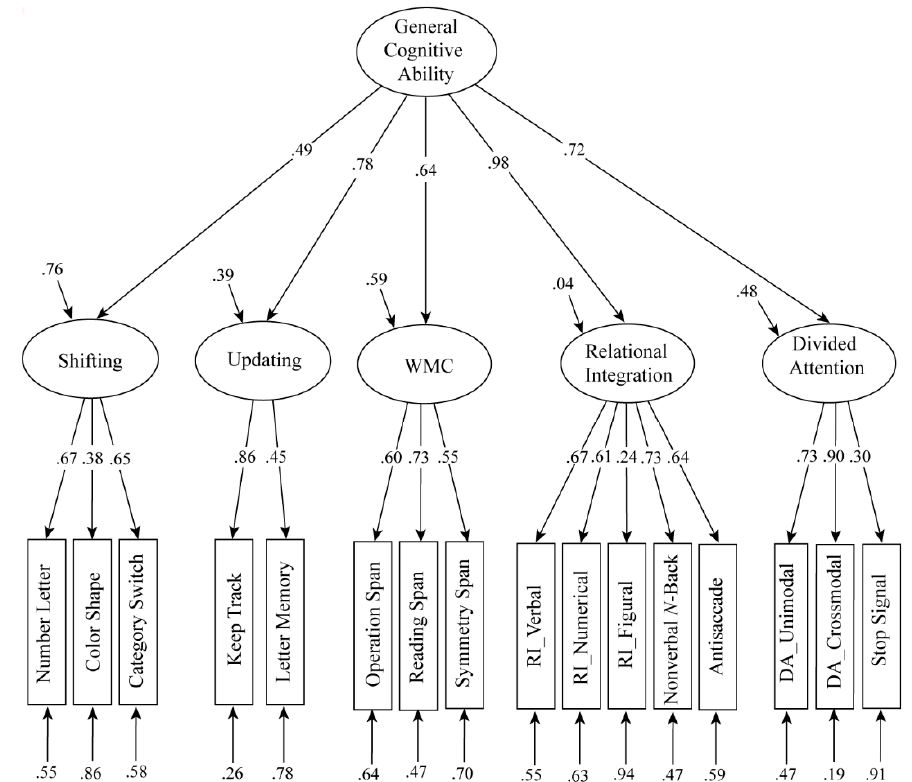
Figure 2. Hierarchical model of cognitive latent variables. The proportion of residual variance of each indicator was calculated by subtracting the variance of the indicator from 1. All parameters were statistically significant ( p < .05). WMC = working memory capacity; RI = relational integration; DA = divided attention.